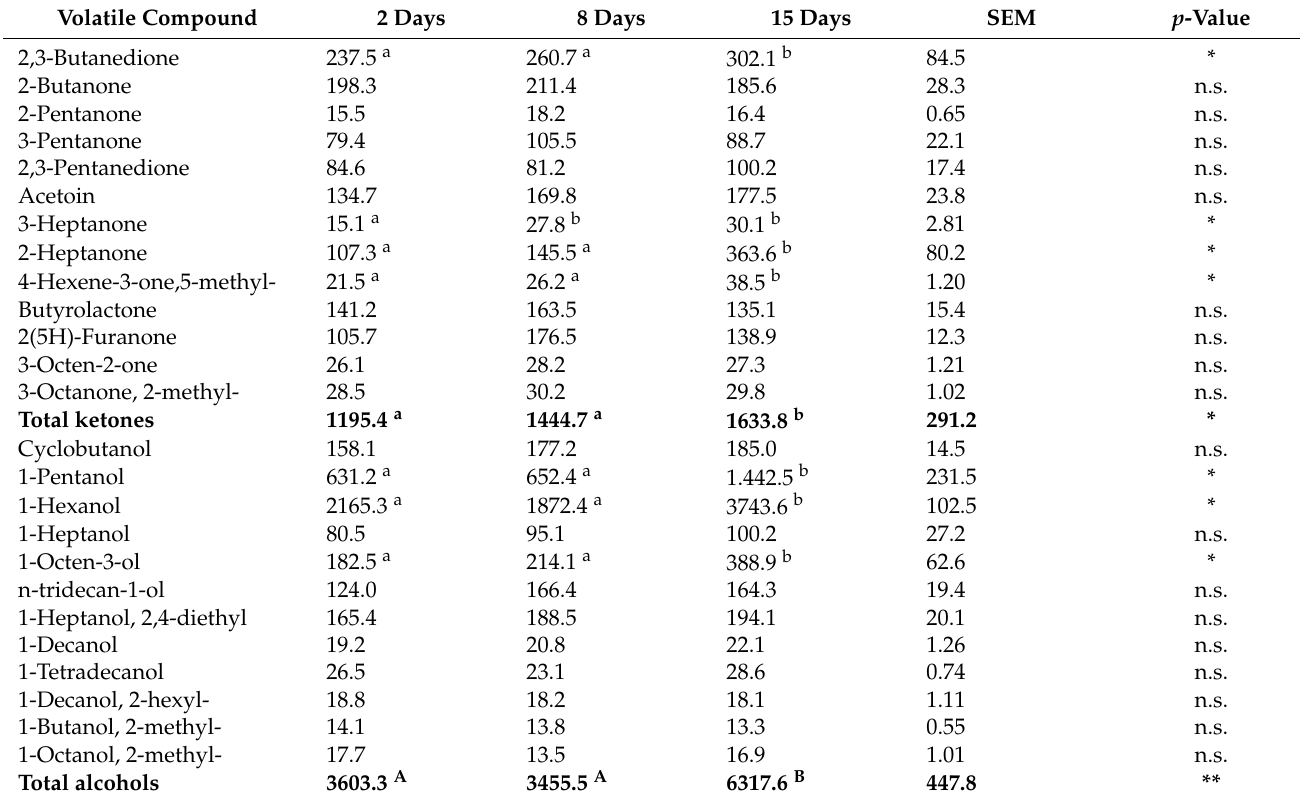
Table 5. Effects of ageing period on donkey meat ketone and alcohol content. (AU × 10 3